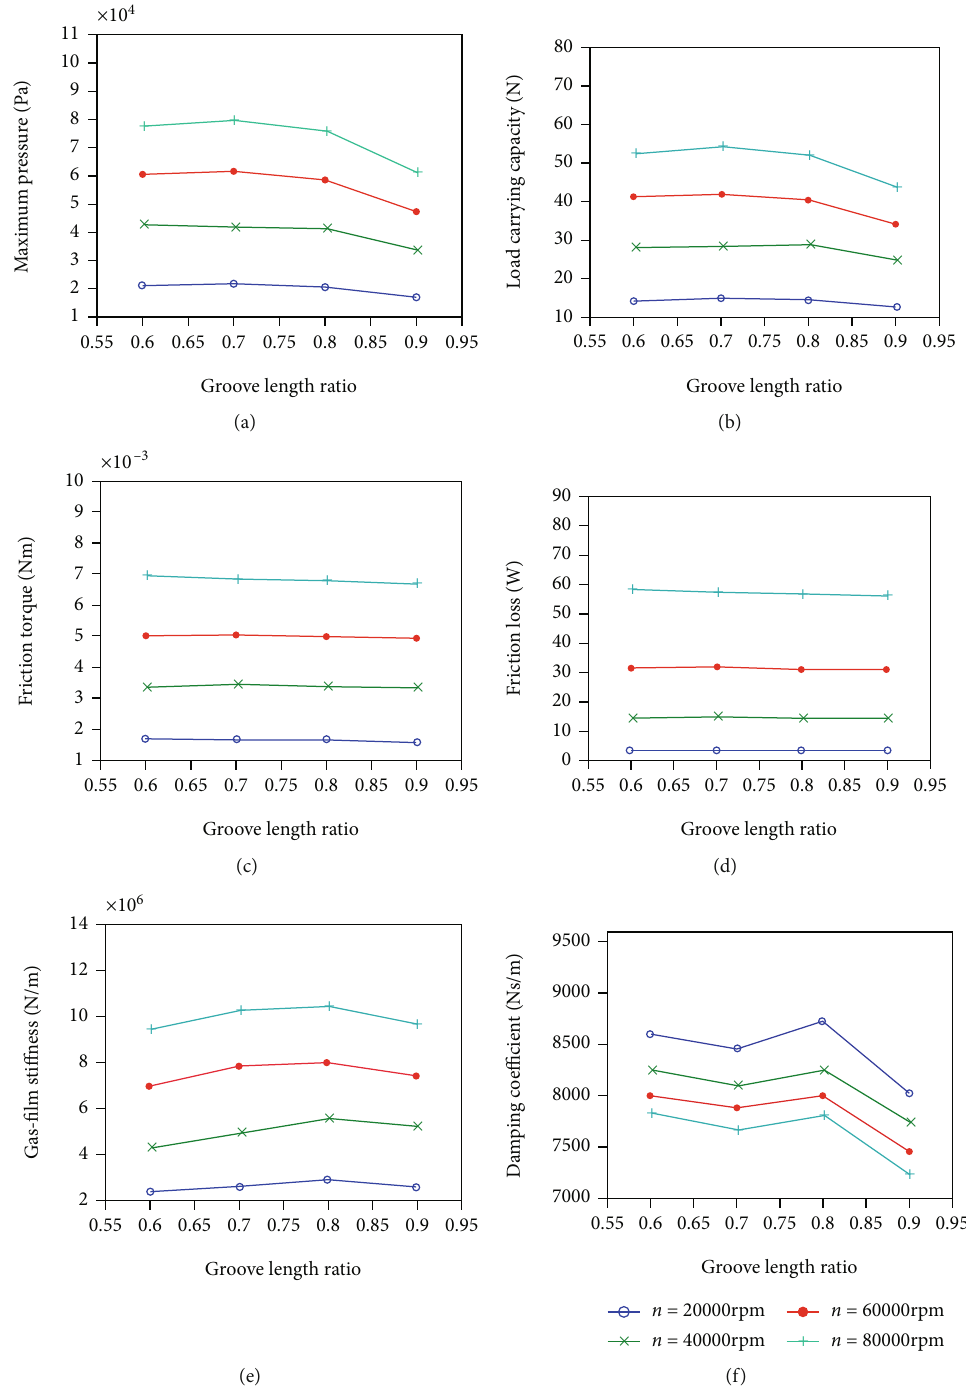
Figure 6: The lubrication performance of spiral-grooved thrust bearing with di ff erent groove length ratios: (a) maximum pressure, (b) load carrying capacity, (c) friction torque, (d) friction loss, (e) gas fi lm sti ff ness, and (f) damping coe ffi the variation of maximum pressure of gas fi lm is obvious at pressure of gas fi lm decreases from 7 : 952 × 10 4 Pa to 7 : 188 × 10 4 Pa at 80000 rpm. The maximum pressure of gas fi lm a higher rotational speed. That is to say, the groove width ratio makes the maximum pressure of gas fi lm decrease espe- for the SGTB with a lower groove width ratio is larger than cially under the high rotational speed condition. Generally, in that of a larger groove width ratio. Moreover, the maximum the lower gas fi lm pressure, the load carrying capacity is pressure of gas fi lm increases as the growth of rotational speed. Combined with the in fl uence of groove width ratio, smaller, as shown in Figure 7(b). The simulation results